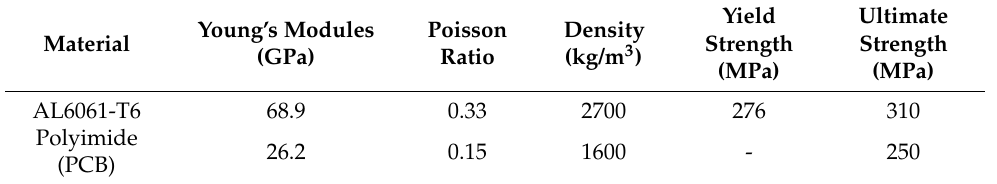
Table 2. FEM material properties of HSDRU.